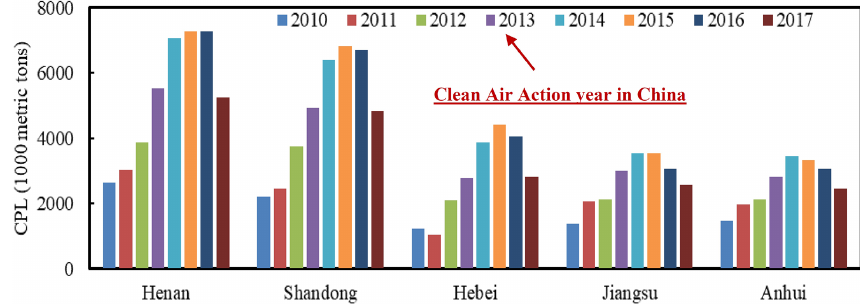
Figure 5. Annual wheat production loss by province from 2010 to 2017 (1000t) due to surface ozone